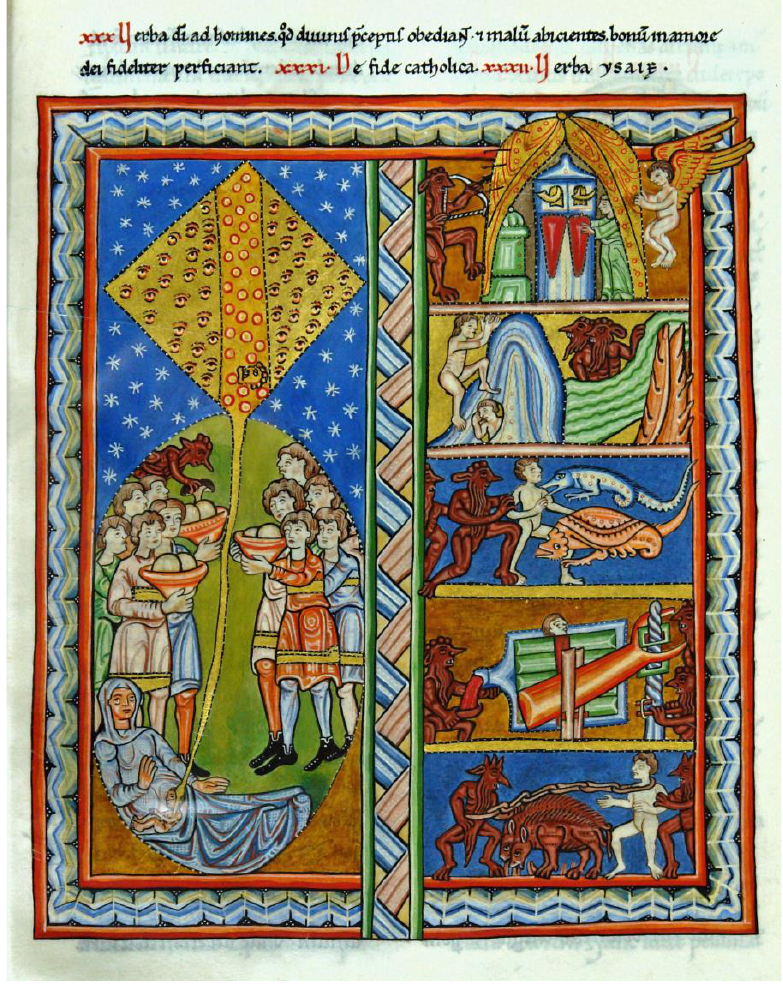
Figure 1. Scivias 1.4: Soul and Body. Rüdesheim/Eibingen, Benediktinerinnenabtei St. Hildegard, MS 1, fol. 22r. By permission of the nuns of the Benediktinerinnenabtei St. Hildegard.